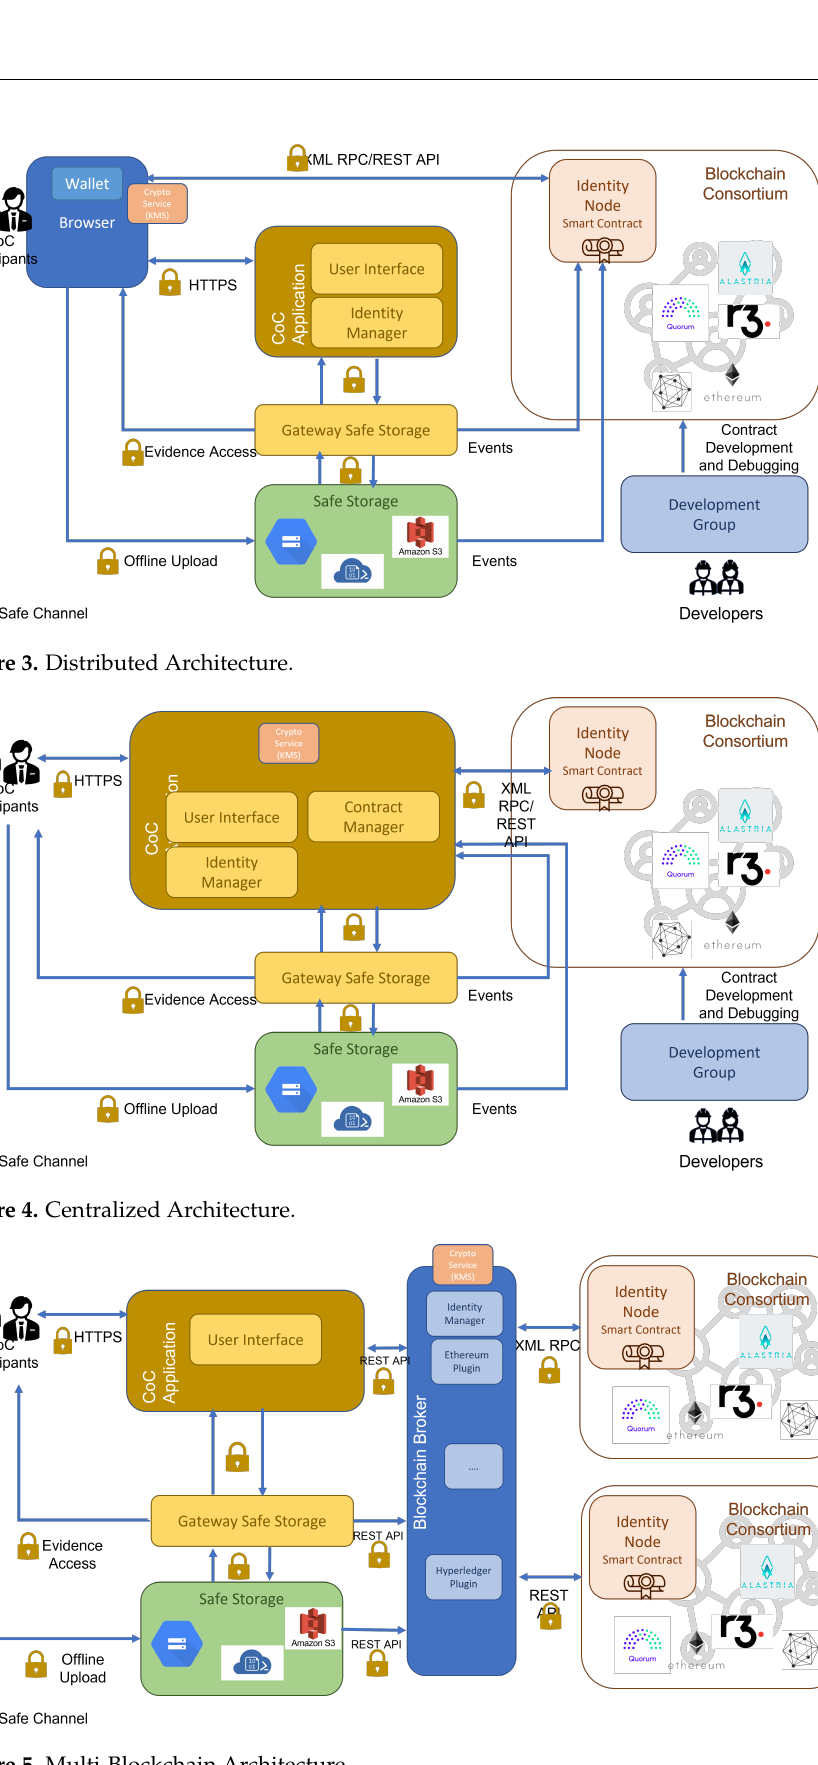
Figure 5. Multi-Blockchain